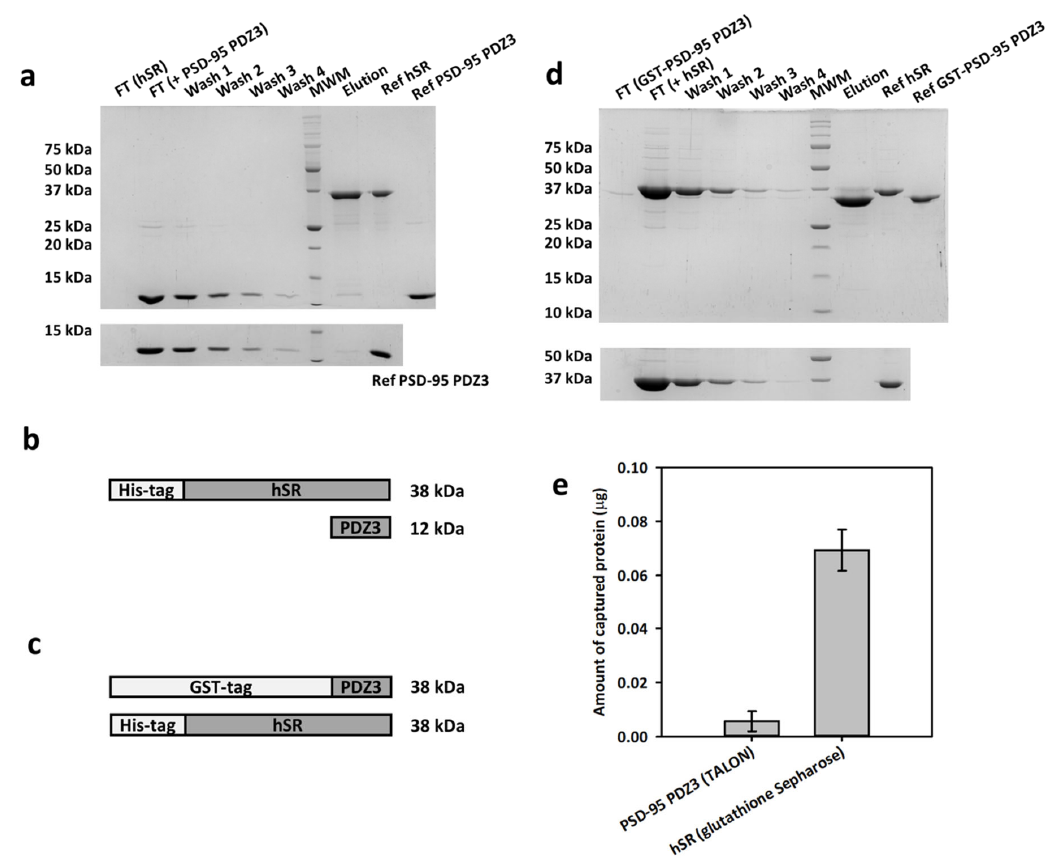
Figure 1. Pull ‐ down assays by immobilizing either hSR or GST ‐ PSD ‐ 95. ( a ) ( Top ) pull ‐ down assay on TALON ® resin, immobilizing His ‐ tagged hSR. FT is the flow ‐ through after protein equilibration; ( bottom ) control experiment with only PSD ‐ 95 PDZ3 loaded onto the resin. ( b ) Scheme of the proteins used for the pull ‐ down experiments with TALON ® resin. ( c ) Scheme of the proteins used for the pull ‐ down experiments with glutathione Sepharose ® resin. ( d ) ( Top ) pull ‐ down assay on glutathione Sepharose ® resin, immobilizing GST ‐ PSD ‐ 95 PDZ3; ( bottom ) control experiment with only hSR loaded. ( e ) Amount of PSD ‐ 95 PDZ3 ( left ) and hSR ( right ) specifically captured by immobilized hSR and GST ‐ PSD ‐ 95 PDZ3, respectively, obtained by the densitometric analysis of the band intensities for each condition. The pull ‐ down experiments were performed in triplicate and the standard error of the densitometric analysis is reported.